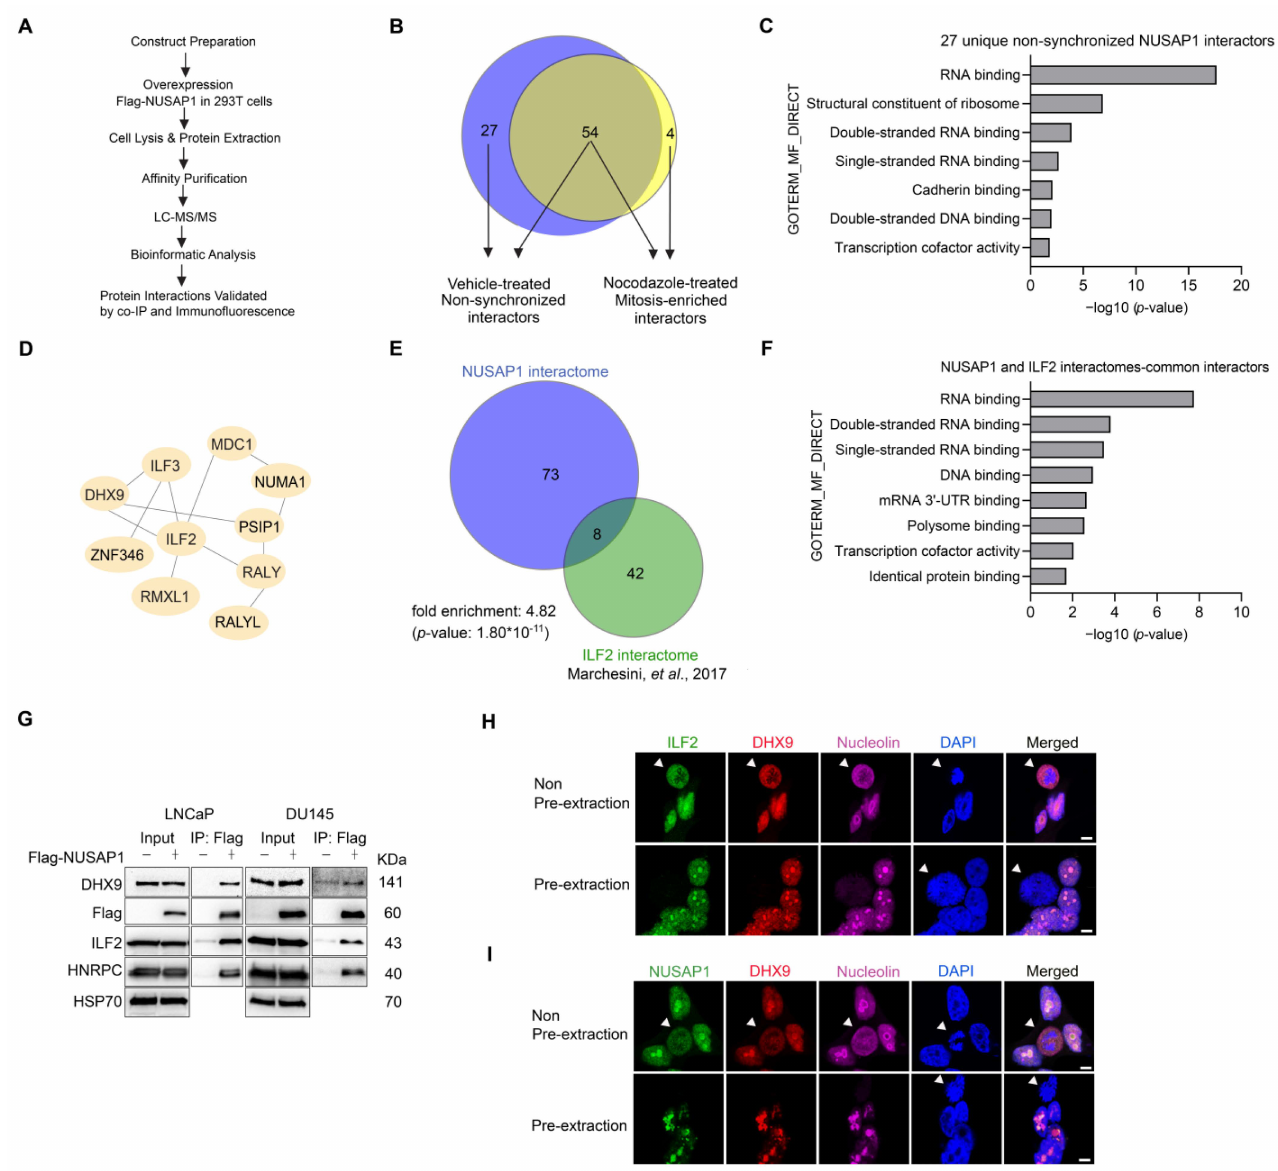
Figure 1. Identification of NUSAP1 interactors, ILF2, and DHX9 by AP–MS. ( A ) Flowchart of AP– MS and verification of protein-protein interactions by co-IP and immunofluorescence. ( B ) Venn diagram of 85 Flag-NUSAP1 interacting proteins identified by AP–MS. Nocodazole induced mitotic arrest of 58 mitosis-enriched proteins while non-synchronized cells (vehicle) identified 81 proteins of which 27 interactors were not mitosis associated. ( C ) Gene ontology (GO) analysis of the molecular functions (MF) of the 27 non-synchronized NUSAP1 interactors by DAVID are enriched for RNA and DNA binding. ( D ) Ingenuity Pathway Analysis (IPA) reveals NUSAP1 interaction with an ILF2/DHX9 protein network. ( E ) Significant overlap 8 interactors between the NUSAP1 and ILF2 interactomes [40] including ILF2 and DHX9. ( F ) Gene ontology (GO) analysis of the molecular functions (MF) of the 8 common interactors between NUSAP1 and ILF2 interactomes by DAVID are enriched for RNA and DNA binding. ( G ) Immunoprecipitation and western blots validate DHX9, ILF2, and HNRPC interactions with Flag-NUSAP1. ( H ) Confocal microscopy shows ILF2 and DHX9 under conventional and pre-extraction conditions. For pre-extraction, cells were permeabilized by 0.5% Triton X-100 before PFA fixation. Under pre-extraction, ILF2 and DHX9 are visualized mainly in the nucleolus, shown by staining with nucleolin. ( I ) NUSAP1 and DHX9 co-localize with nucleolin in LNCaP cells. Arrowheads indicate mitotic cells. Scale bar = 10 µ